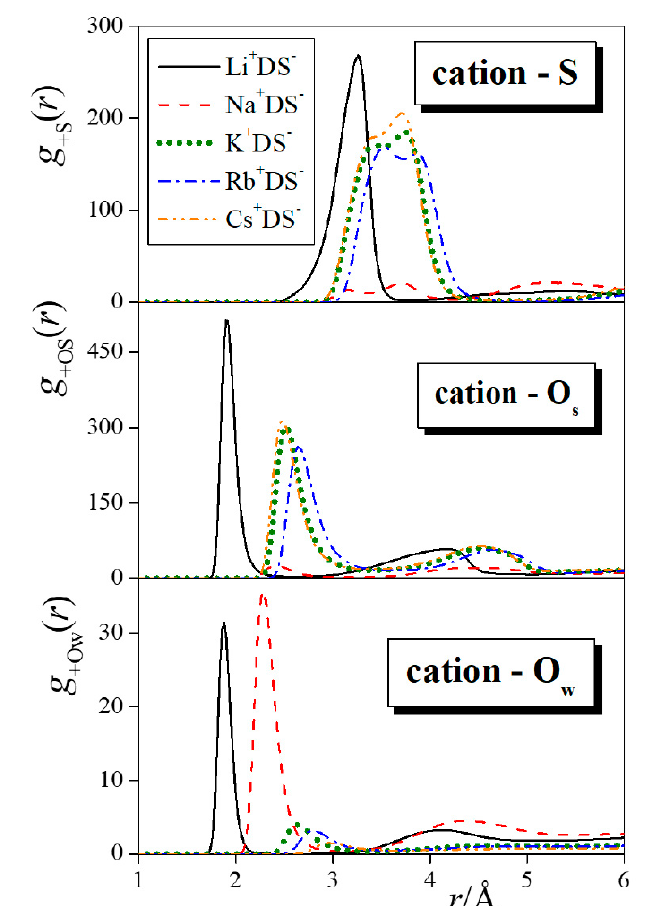
Figure 3. Radial distribution functions between the alkali counterions and the sulfate S atoms (top panel), sulfate O atoms (middle panel), and water oxygen atoms (bottom panel), as obtained in the systems consisting of Li + (black solid curves), Na + (red dashed curves), K + (green dotted curves), Rb + (blue dash-dotted curves), and Cs + (orange dash-dot-dotted curves) counterions.